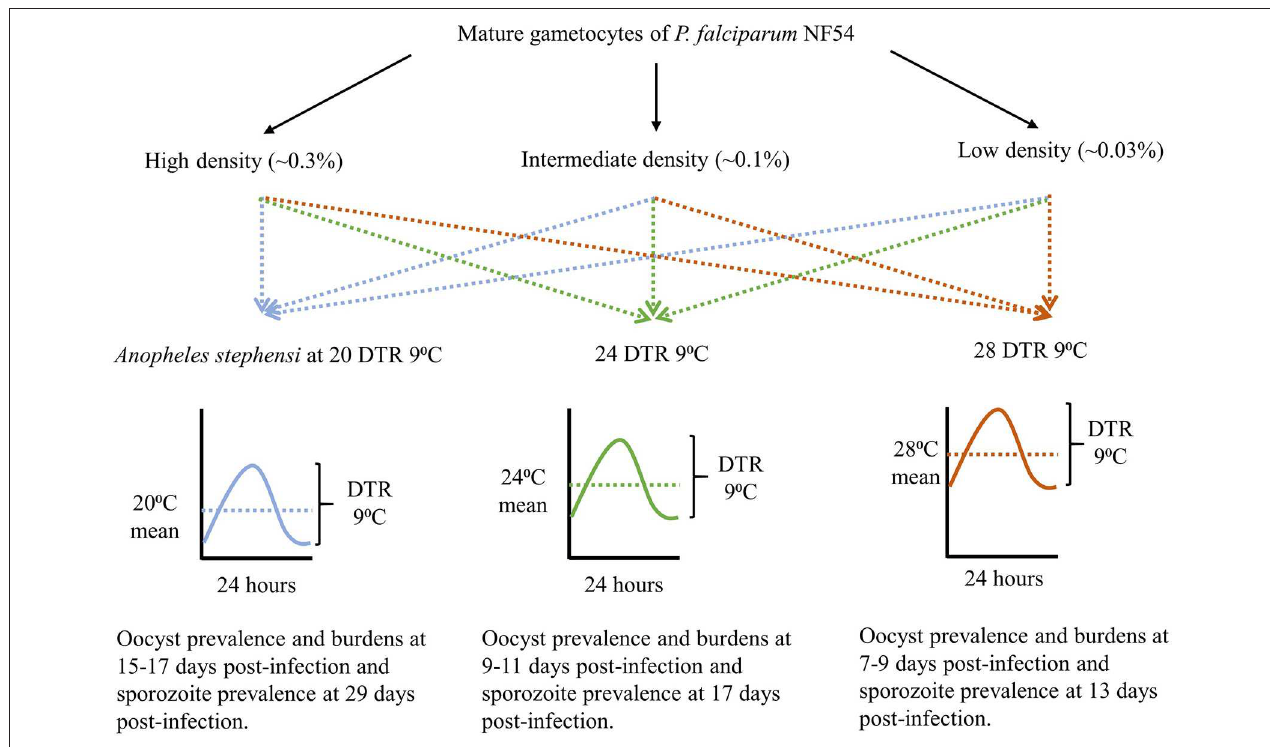
FIGURE 1 | The study design showing gametocyte densities, temperature regimes, and time of sampling for each temperature, to account for the differences in development